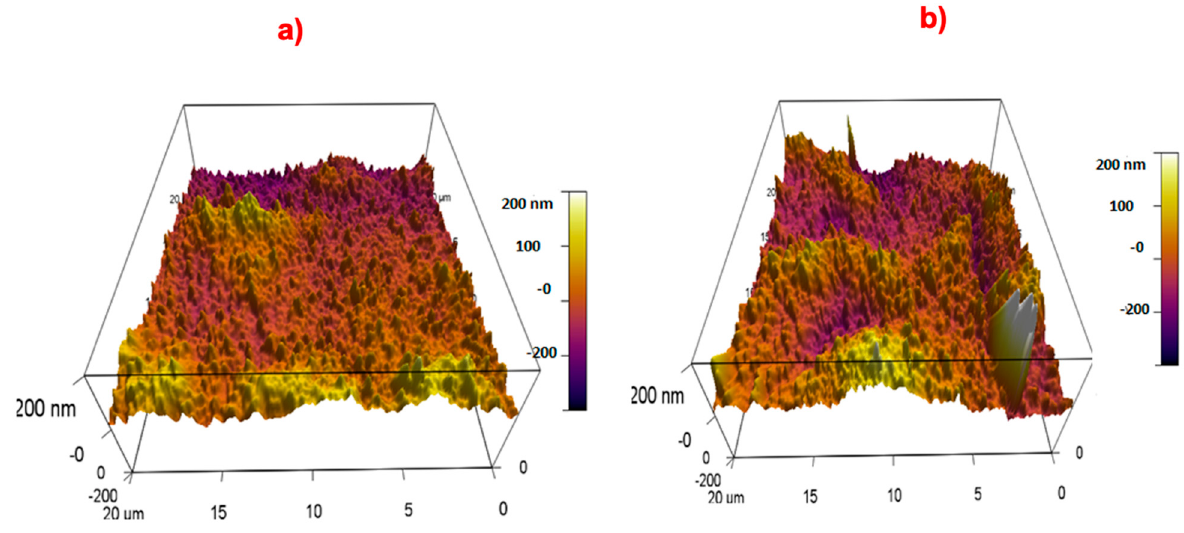
Figure 12. AFM images 3-dimensional view of: ( a ) CA–PEG recorded volume hologram; ( b ) CA–PEG recorded volume hologram exposed to water (spatial frequency 800 linepairs/mm).